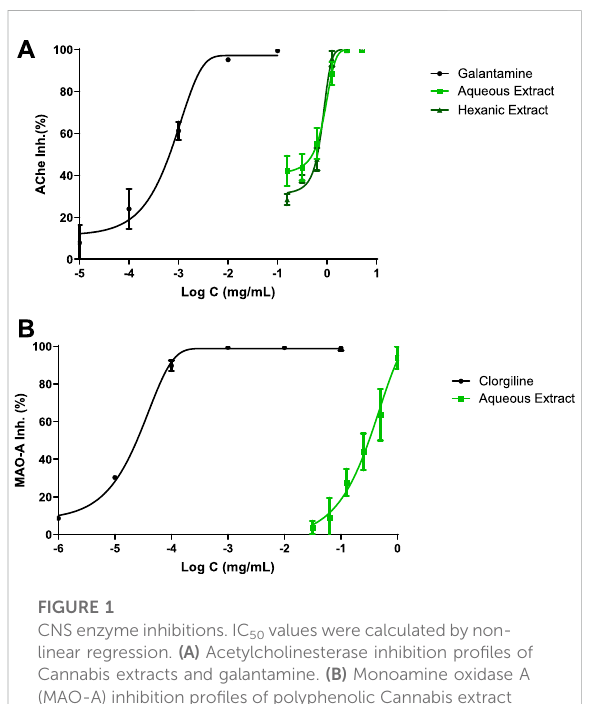
CNS enzyme inhibitions. IC 50 values were calculated by non- linear regression. (A) Acetylcholinesterase inhibition pro fi les of Cannabis extracts and galantamine. (B) Monoamine oxidase A (MAO-A) inhibition pro fi les of polyphenolic Cannabis extract and clorgiline.